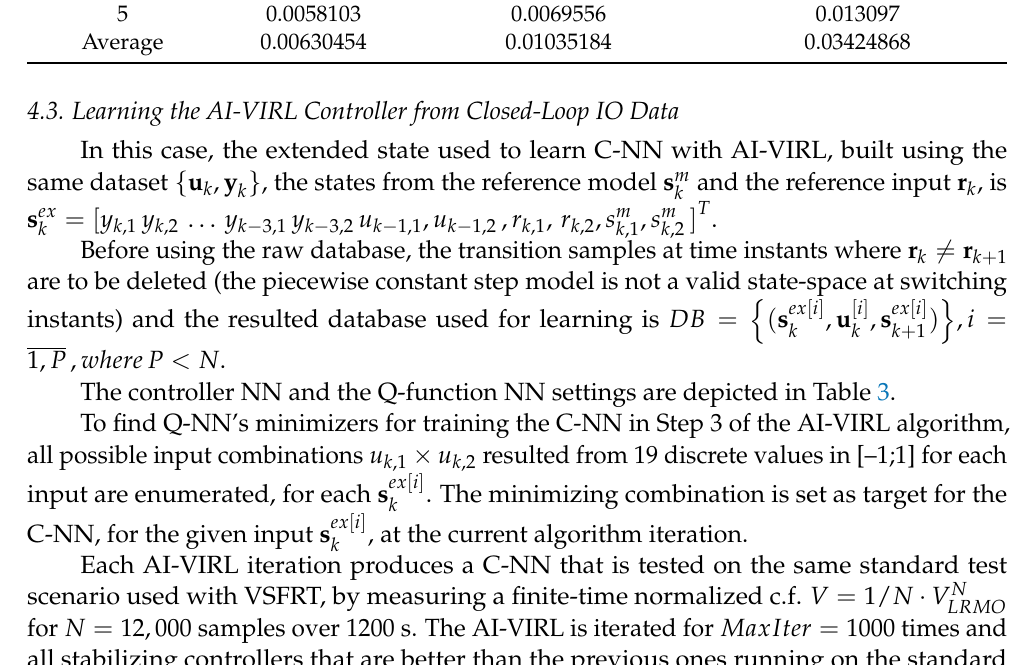
Table 2. VSFRT and Approximate Iterative Value Iteration Reinforcement Learning (AI-VIRL) tracking performance when learning uses closed-loop IO data.